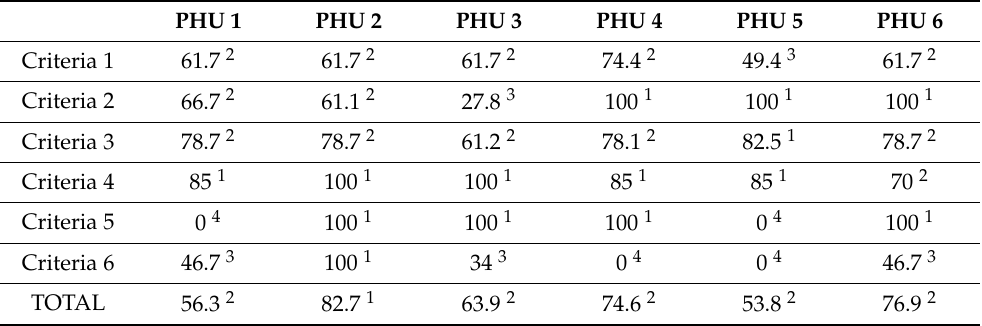
Table 3. Percentage of compliance with EAAB criteria and classification in the implementation score, Bras í lia, FD,